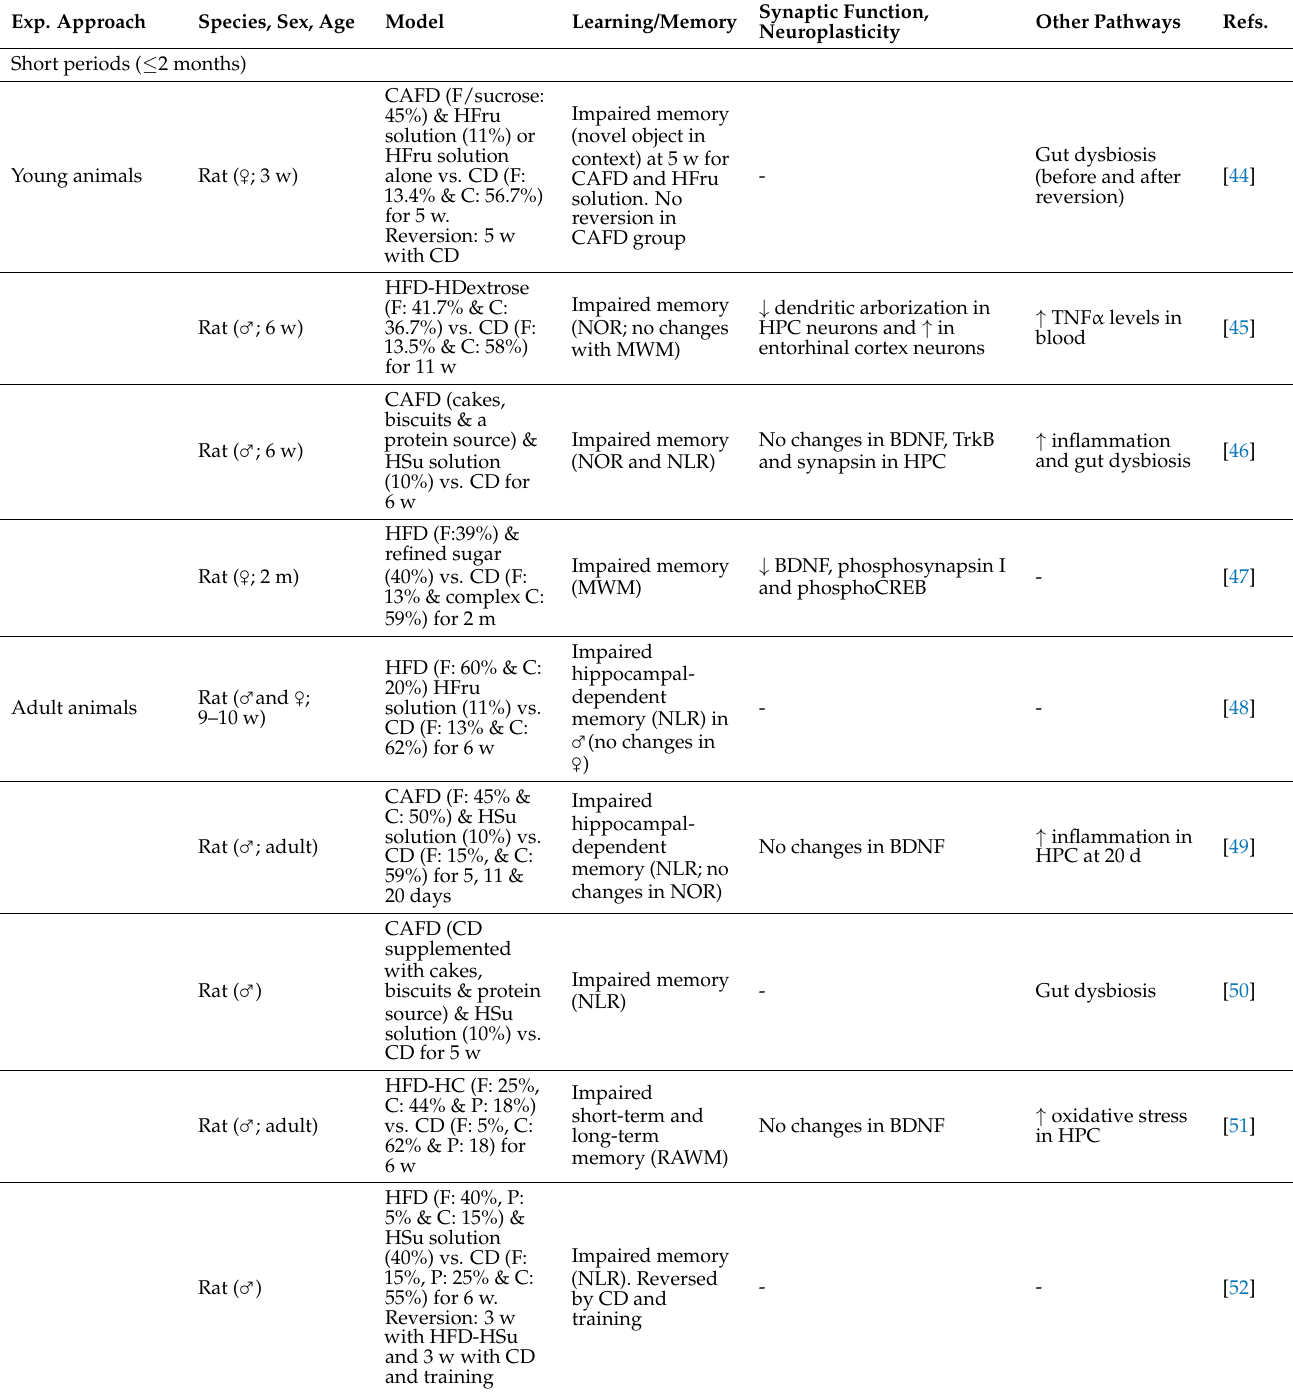
Table 1. WD effects on synaptic function and cognition in